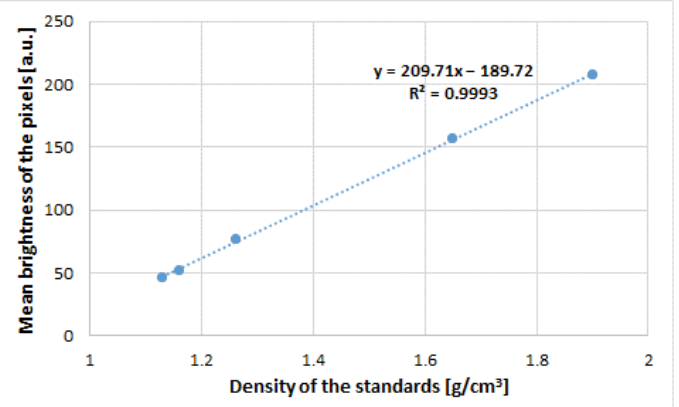
Figure 3. The correlation between the brightness of the pixels and the density of the standards from the calibration phantom.